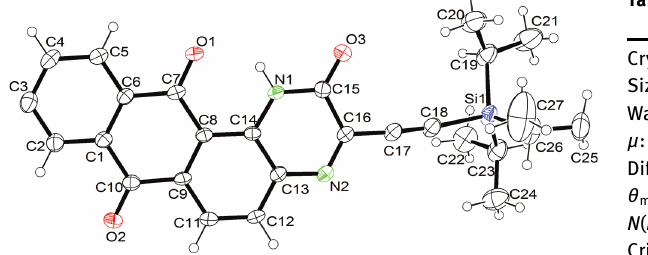
Table 1: Data collection and handling.